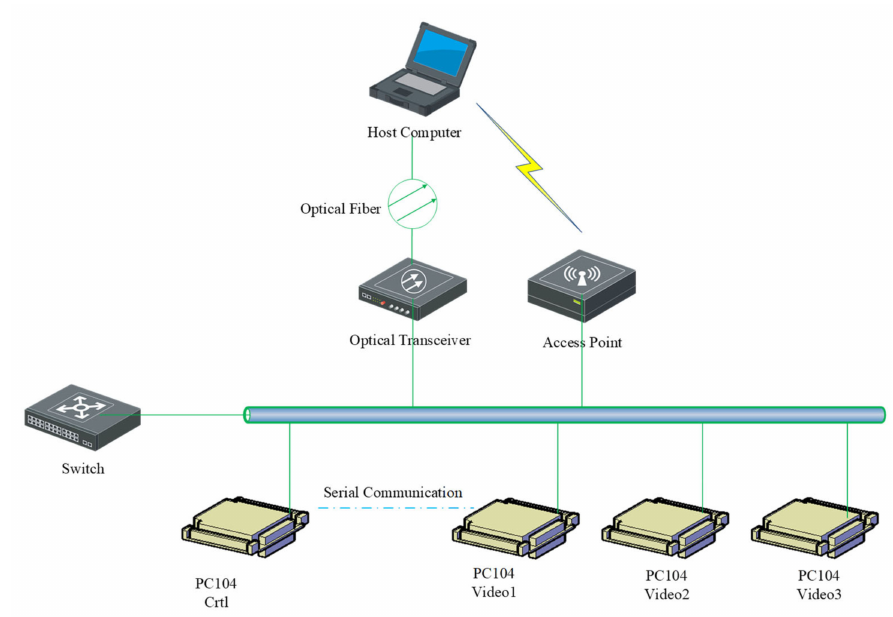
Figure 8. Model of the heterogeneous dual-line dual-CPU hot redundancy